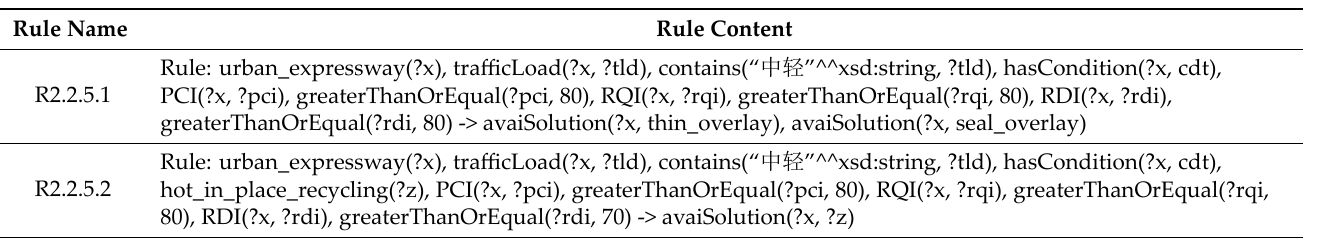
Table A4. Renewal rules for expressways with pavement irregularities and moderate/mild traffic